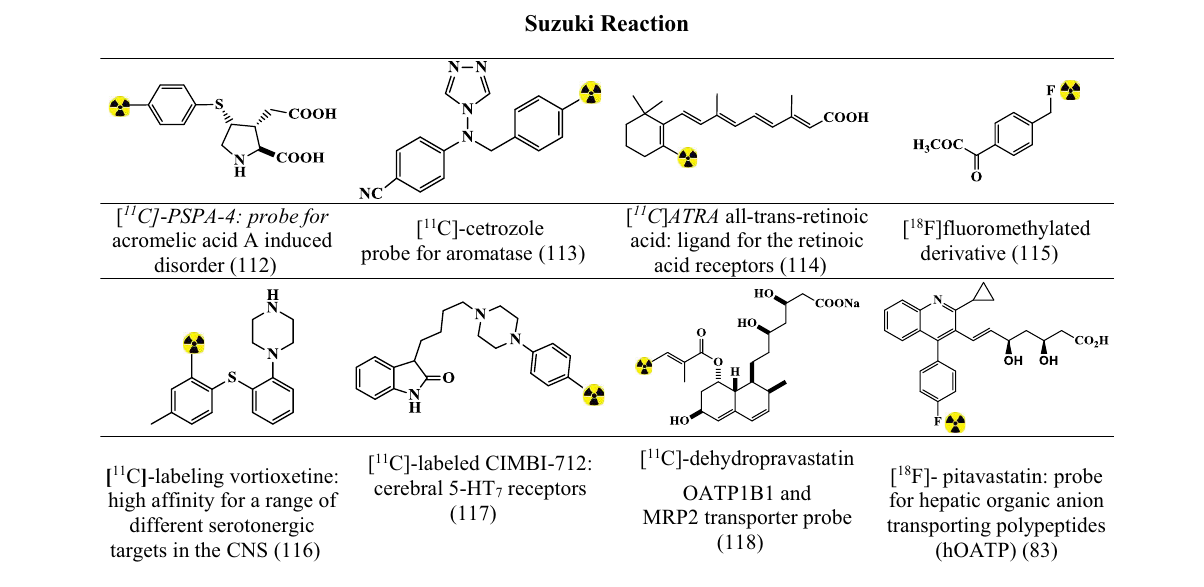
FiGURe 8 | Selected structures developed using Suzuki reactions. Structures referenced in (80, 82, 83,